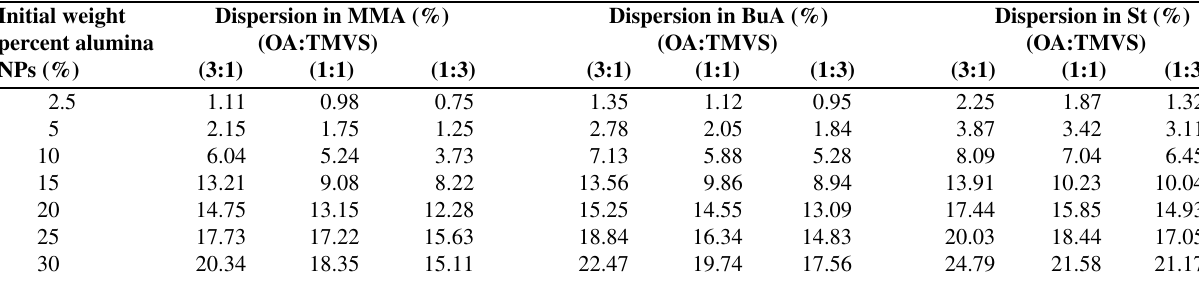
Table 3: Dispersion of alumina NPs modified with different ratios of mixtures of OA: TMVS (3:1, 1:1 and1:3) in some organic media (%). Initial weight Dispersion in MMA (%)